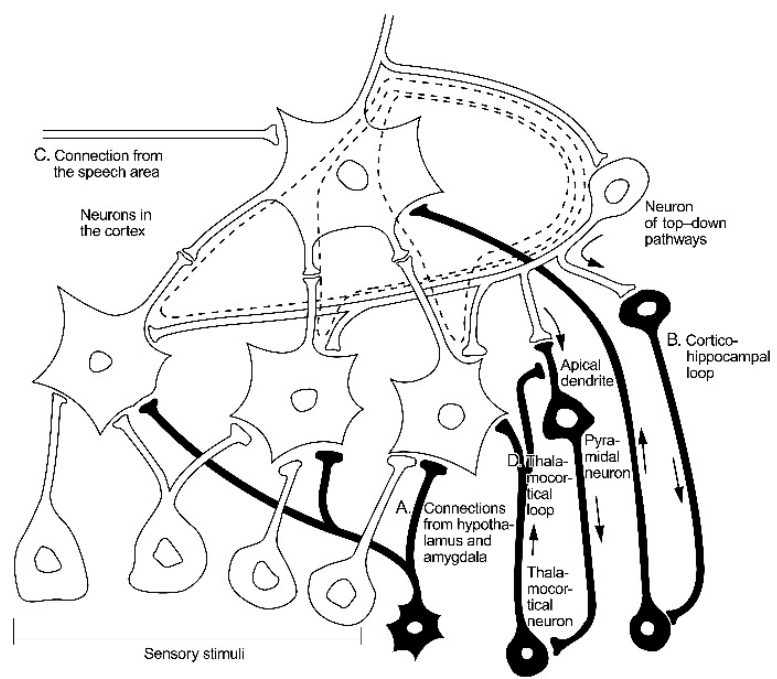
Figure 3. Diagram of the circuits responsible for perceptions and recalling of mental images. Diagram of hierarchical structure of neurons integrating sensory information. The long-term memory is consolidated under the influence of connections from the hypothalamus and amygdale (A). The cortico-hippocampal loops (B) are elements of the working memory system recalling mental images. The activation of the object neuron by the cortico-hippocampal loop induces recurrent reactivation of neurons in lower layers. The dotted line indicates the circuits of repetitive propagation of stimuli in the upper layers of the hierarchical structure, which is the essence of imaginary. The activation of an object neuron can also be evoked from the side of the speech area (C). The thalamo-cortical loop (D) reach the lower parts of the cortex. The oscillations in these circuits happens e.g., in periods of a deep sleep. The element “D” of the diagram emphasize that the brain’s actions are based on an intrinsically generated neuronal activity and that the sensory inputs are acting as modifiers of such intrinsic activity. The figure facilitates the understanding of why perceptions and imagery stimulate further oscillations in the upper layers of the hierarchical structure.